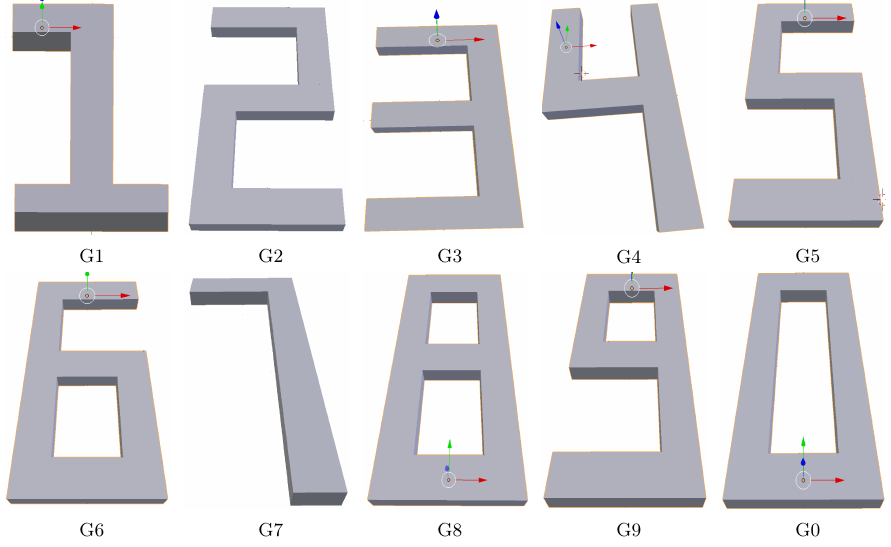
Figure 4: CAD models of the complex simulations. Each geometry is 8 layers thick and have distinct printing pattern. distinct printing